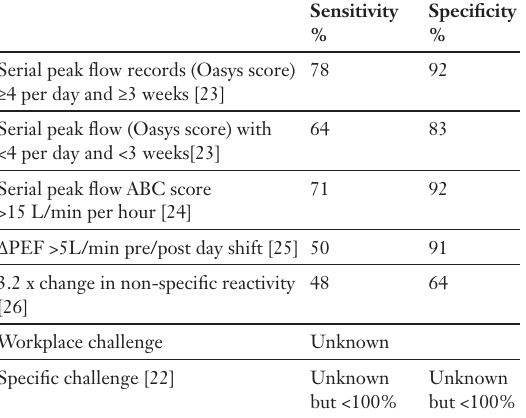
Sensitivity and specificity of different physiological tests for occupational